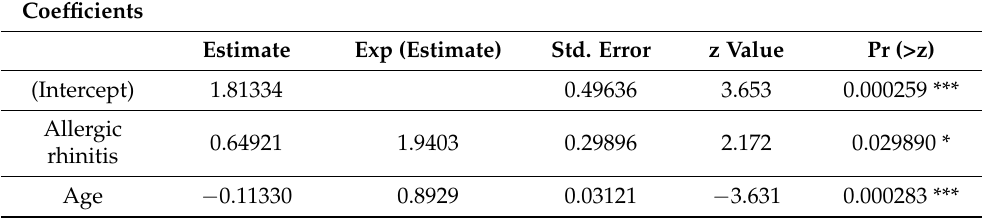
Table 3. Multiple regression model on the effect of age and allergic rhinitis on malocclusion (Cross- bite/Ogival